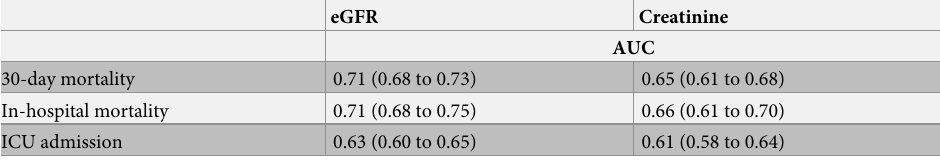
Table 4. Discriminative performance of eGFR and serum creatinine for the prediction of the different